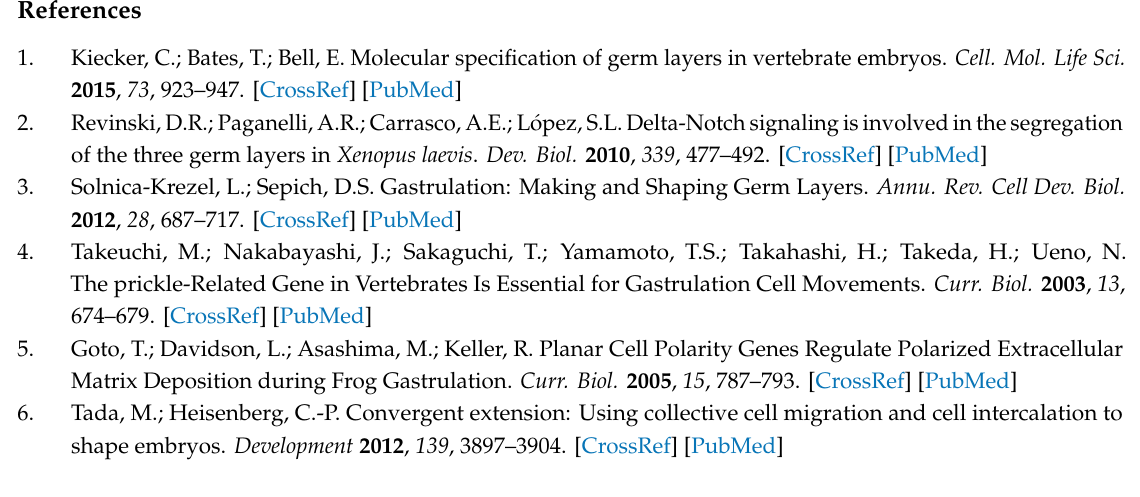
Figure S1: Genomic structure of the Xenopus tropicalis Hes5.9 gene, Figure S2: The WISH of gastrulation embryos and transversal section, Figure S3: Three kinds of Hes5.9 -MOs e ffi ciently knockdown Hes5.9 , Table S1: Ex.1 OvervsCtrl_all.DEG_KEGG_pa, Table S2: